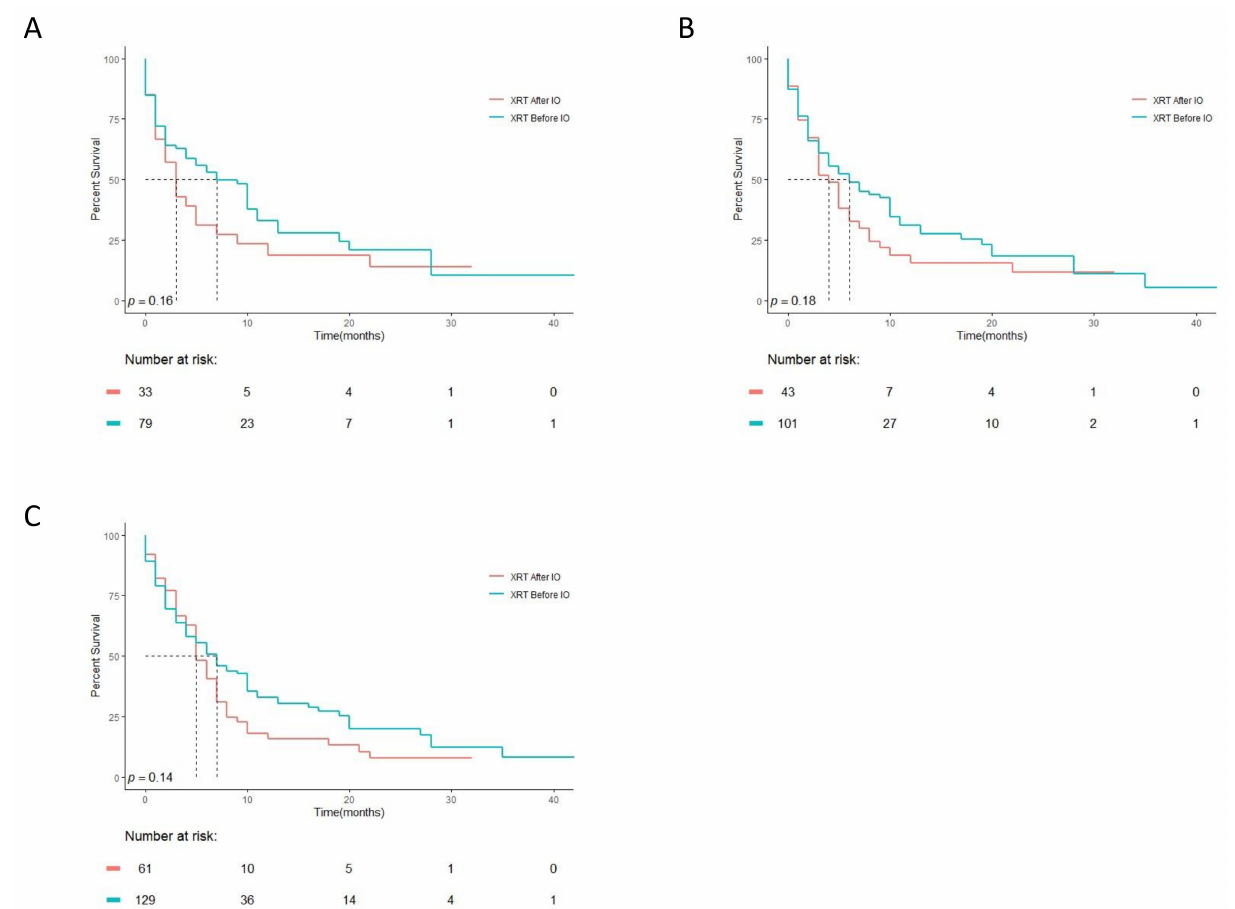
Figure 2. Kaplan–Meier overall survival comparison of patients given XRT before or after IO initiation, within one month before or after IO initiation ( A ), within 3 months ( B ) or within six months before or after IO initiation ( C